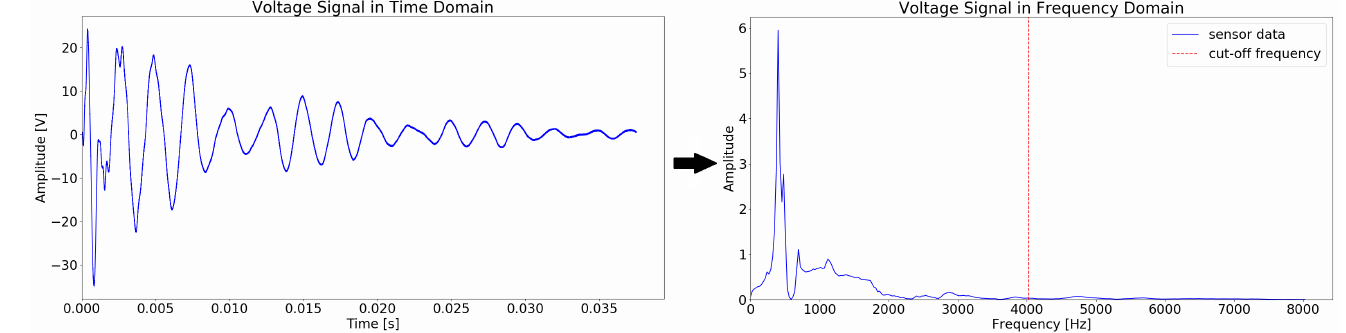
Figure 4. Transformation of the time series signal into a frequency domain using a Fast Fourier Transform. The red line marks the high end of the passband frequency range, with 0 Hz being the low